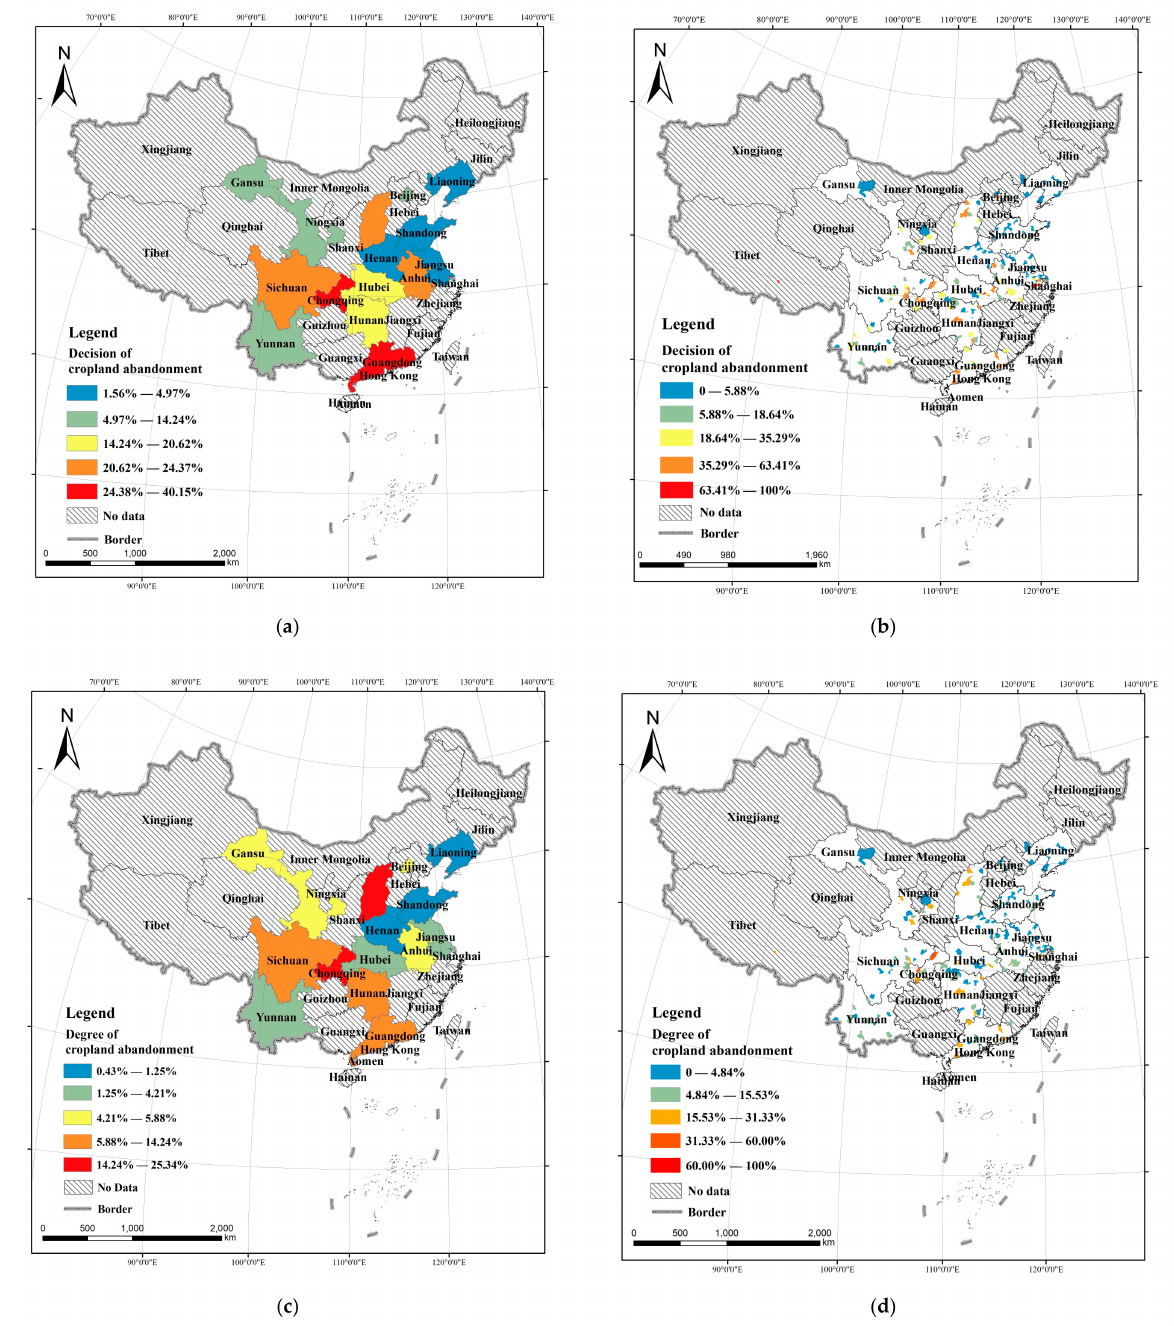
Figure 2. Cropland abandonment levels and spatial distribution map of degrees of